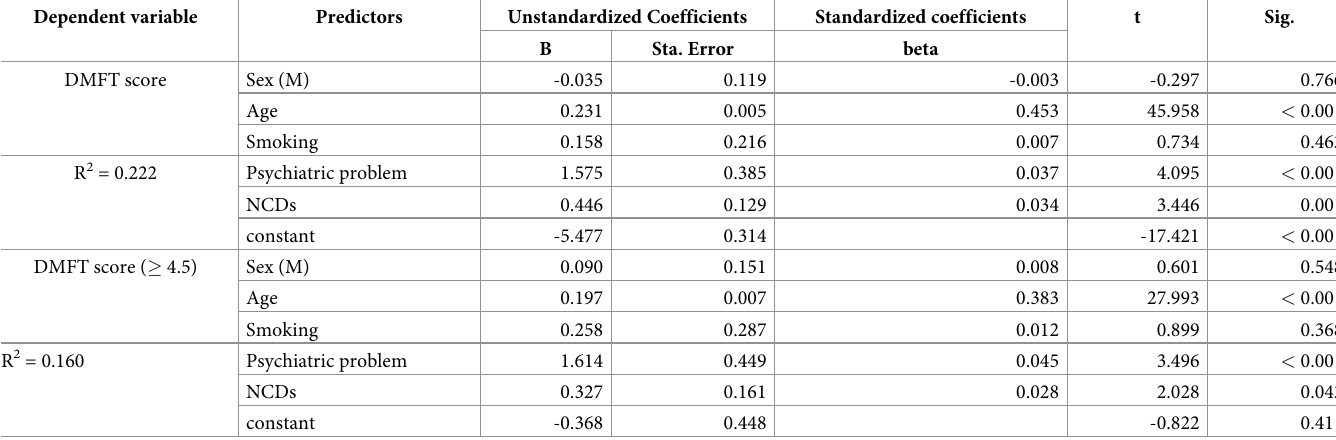
Table 3. Multiple regression analysis of effect of risk factors on DMFT